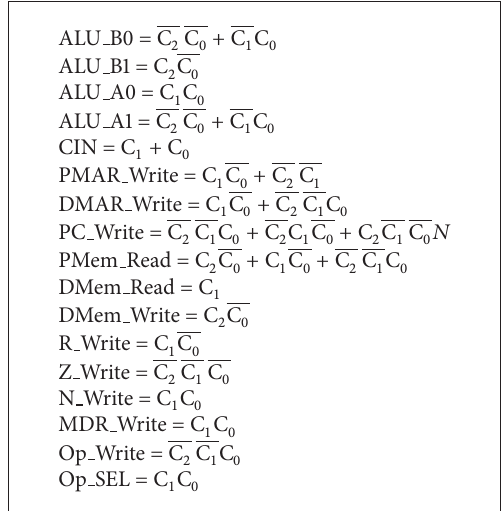
Algorithm 2: The Boolean expression of the CISA FSM